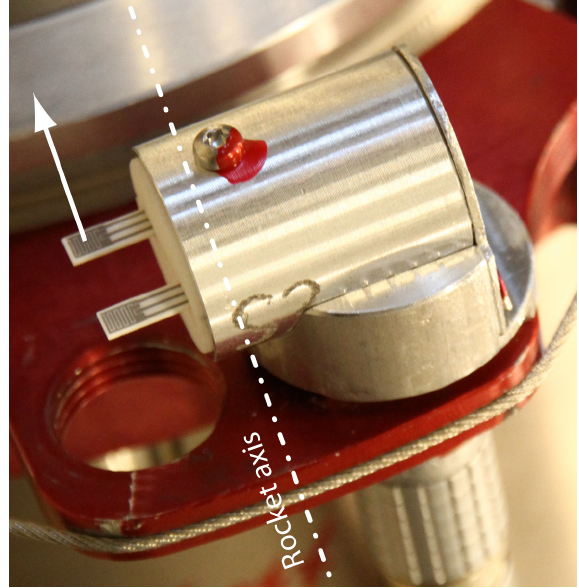
Figure 7. Modified sensor head with orientation of the electrode surface perpendicular to the payload